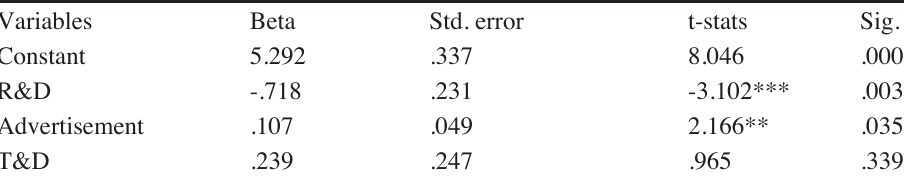
Table 5. Regression Results for Cement